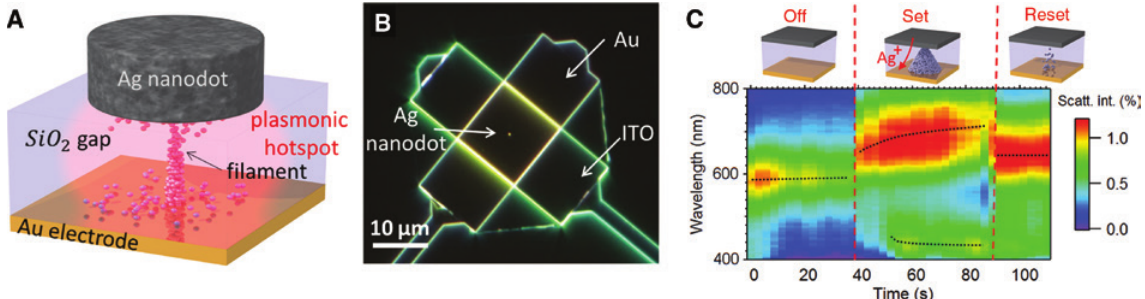
Figure 6: (A) Sketch and (B) SEM of NPoM memristive cell and (C) its optical response upon electrical switching. Reprinted with permission from Ref. [58], Copyrights 2016 by WILEY-VCH Verlag GmbH & Co. KGaA,